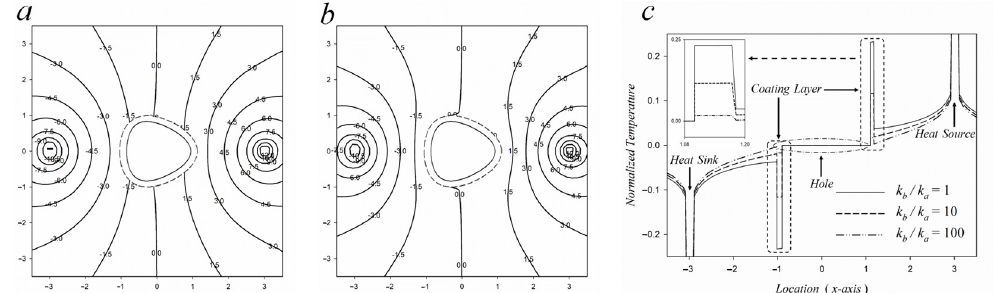
Figure 5. Contours of temperature distribution for a coated equiangular triangle hole, where ( a ) k b /k a = 10 and ( b ) k b /k a = 100. ( c ) Quantitatively normalized temperature for a coated triangular hole with different ratios of heat conductivity, where w = 0.1.